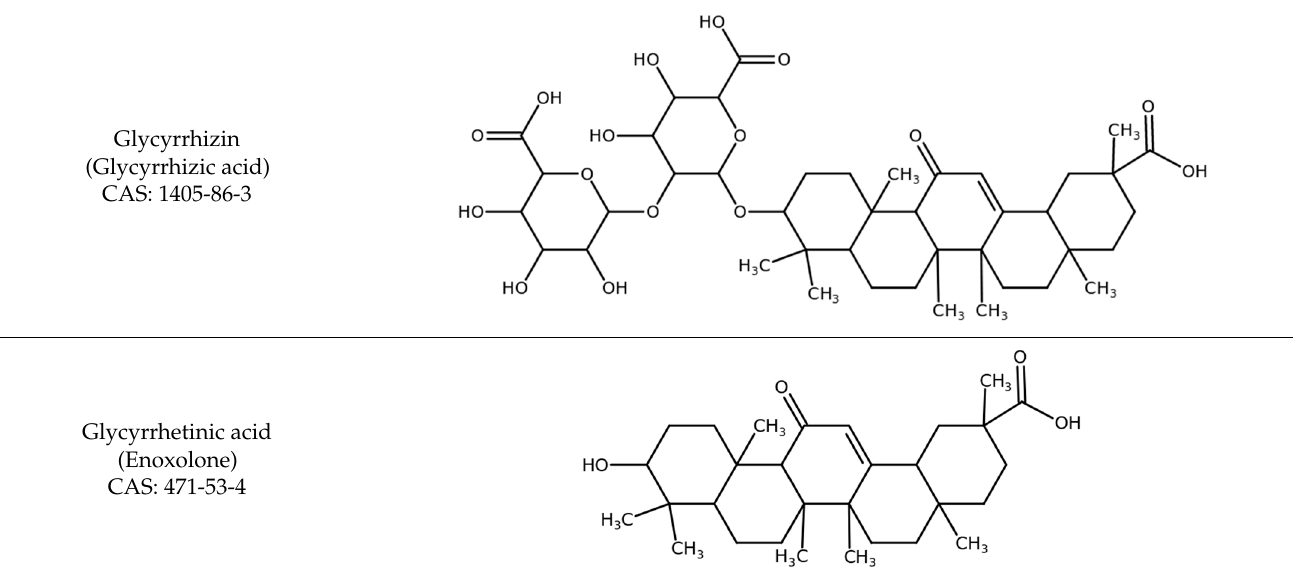
Table 1. Chemical structures of compounds in licorice root extracts with their most widely used names and CAS registry number. Data retrieved from PubChem.